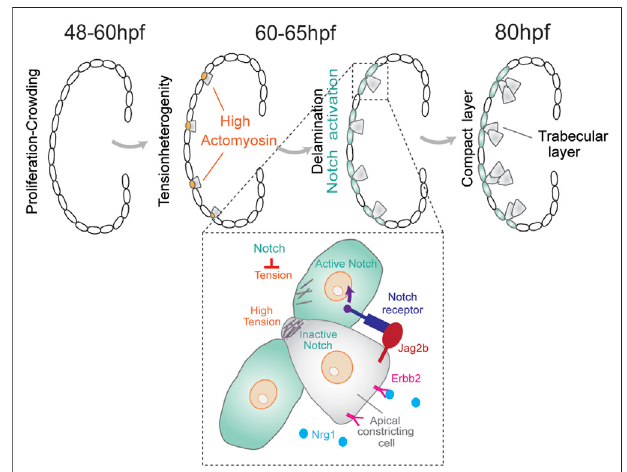
FIGURE 1 | During cardiac trabeculation in zebra fi sh (between 60 and 65 hpf), proliferation-induced crowding leads to tension heterogeneity in cardiomyocytes. CMs with higher tension constrict their apical domain and delaminate to seed the trabecular layer. This delamination triggers activation of Notch signaling in adjacent compact layer CMs, thereby establishing a distinct CM fate for these two layers. The coordination between Notch and Erbb2 pathways between neighboring cells produces a distinctive pattern of cell shape and fate for the trabecular and compact layer